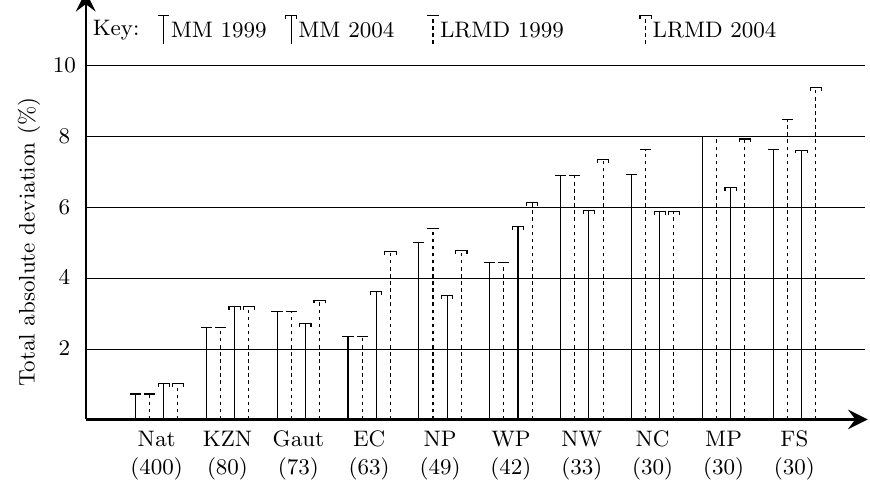
Figure 3: The total absolute deviation (as a percentage) for the allocation of seats using math- ematical programming and LRMD. The data for the 1999 and 2004 elections in South Africa were used. The value in brackets is the total number of seats that must be allocated for that region. The following abbreviations are used: Nat for national, KZN for KwaZulu Natal, Gaut for Gauteng, EC for Eastern Cape, NP for Northern Province (Limpopo), WP for Western Cape, NW for North West, NC for Northern Cape, MP for Mpumalanga and FS for Free